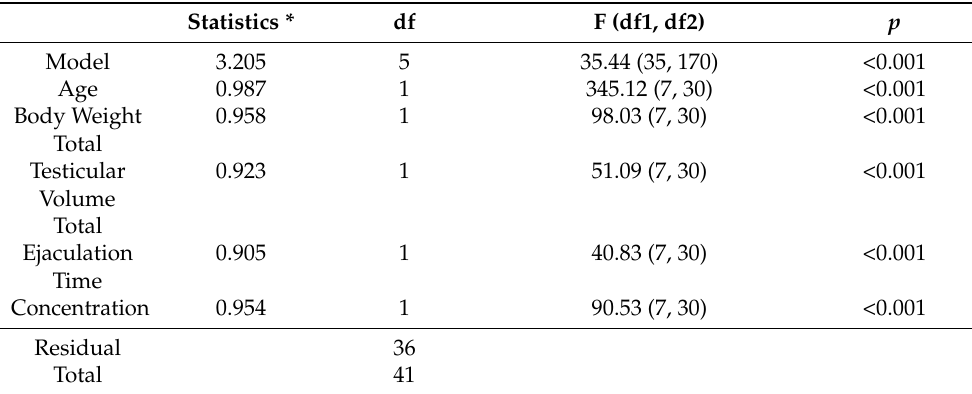
Table 3. The results of the overall multivariate test ( n =